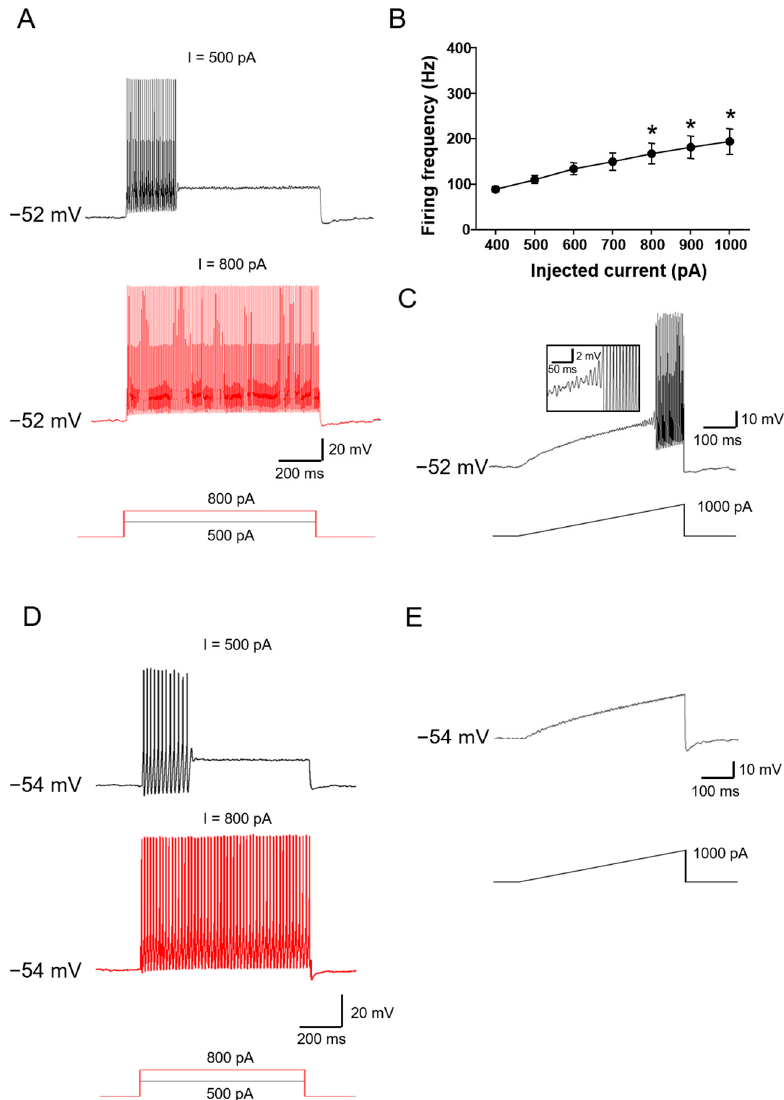
Figure 2. Characteristics of Class 2 large DRG neurons. ( A – C ) showing a representative example of Class 2-1 neuron. ( A ) Current steps were injected into the patched somas through recording electrodes and are shown below the corresponding recording traces. At an RMP of − 52 mV, when injected with increasing intensity of depolarizing current steps, this group of neurons fires more action potentials, but at a constant frequency ( n = 8); ( B ) I-F curve revealed that the firing frequency in this class of neurons is independent on stimulus intensity applied (Uncorrected Fisher’s LSD one-way ANOVA, F(6,45) = 4.411, p = 0.0014; in multiple comparisons, * p < 0.05 vs. 400 pA injection); ( C ) Current ramps were injected into the cell and induced repetitive action potential firing. This subclass of Class 2 neurons (Class 2-1) displayed rhythmical bursting with subthreshold membrane potential oscillations in response to current ramps. Insets show magnified subthreshold membrane potential oscillations. Note that ( A , C ) are recorded from the same neuron ( n = 17); ( D , E ) A representative example of Class 2-2 neuron; ( D ) Repetitive action potential firings in response to different current steps shown below; ( E ) Current ramp injection did not induce any action potential firing in this subclass of neurons ( n = 7).